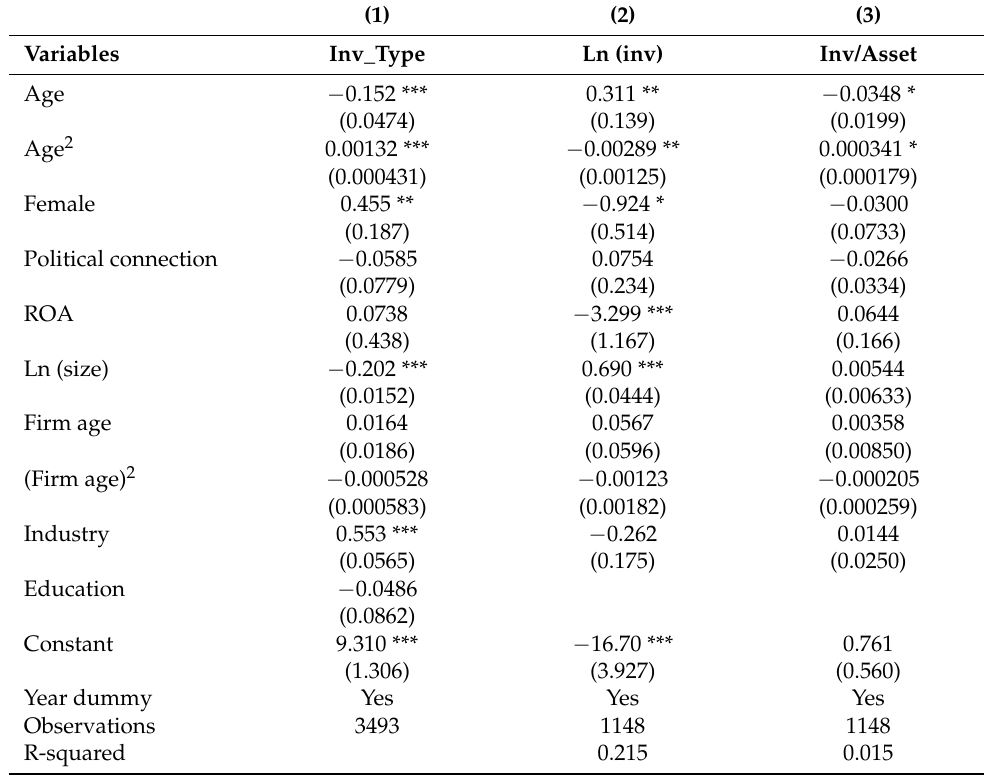
Table 7. Robustness